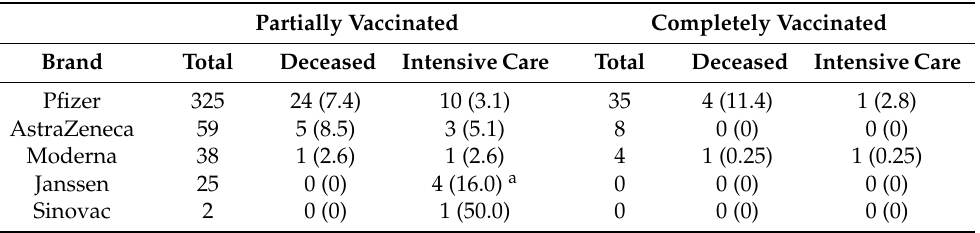
Table 2. Patients with COVID-related death or admitted to the Intensive Care Unit were segregated with respect to the brand of vaccine administered. Partially Vaccinated Completely Vaccinated